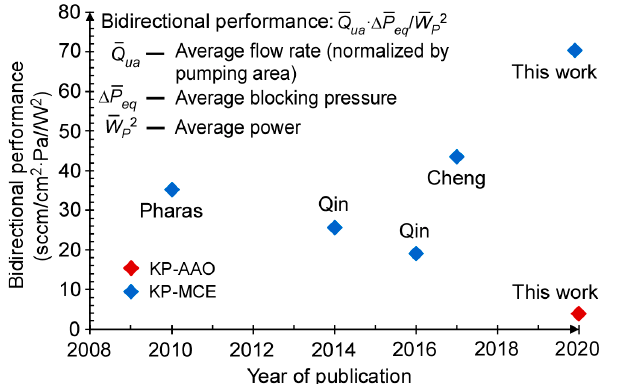
Figure 14. Comparison of bidirectional performance among prior and 3D-printed bidirectional KPs. The bidirectional performance was improved by 1.5–2-fold compared prior KPs.